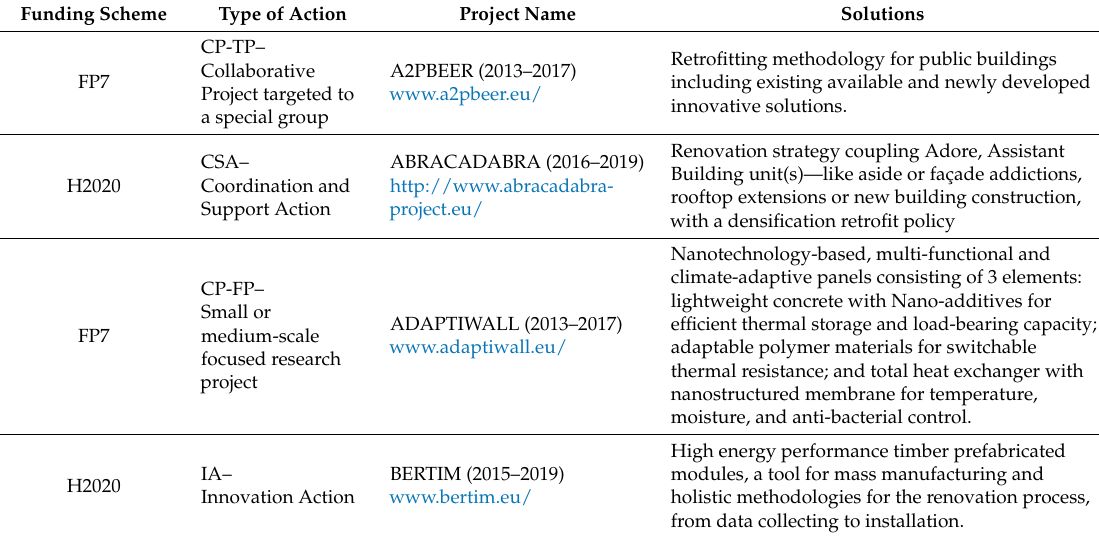
Figure 1. List of 31 reviewed EU-funded projects that deal with state-of-the-art deep renovations [3]. Table 2. Deep renovation solutions of state-of-the-art EU-funded projects.